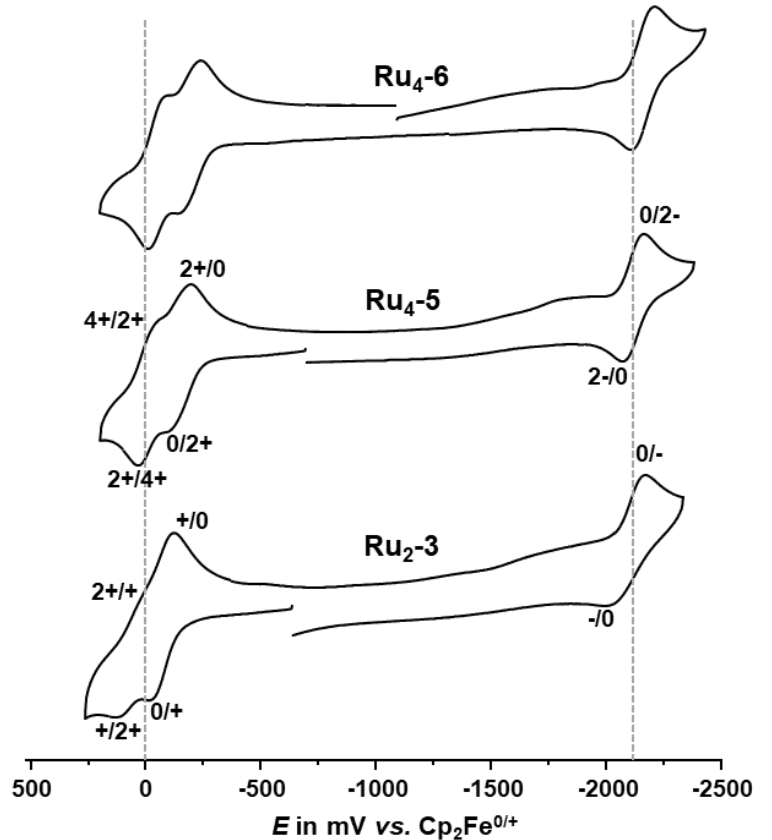
Figure 4. Cyclic voltammograms of Ru 4 -5 , Ru 4 -6 , and their diruthenium precursor Ru 2 -3 (THF, 0.1 M NBu 4+ PF 6 − , 295( ± 3) K, scan rate v = 100 mV/s). The dotted grey lines represent the (overall) half-wave potentials of the oxidations and reduction of complex Ru 2 -3 ; they are intended as a guide to the eye. Table 1. Cyclic voltammetric data of Ru 2 -3 , Ru 4 -5, and Ru 4 -6 1 . E 1/20/+ ( ∆ E p )